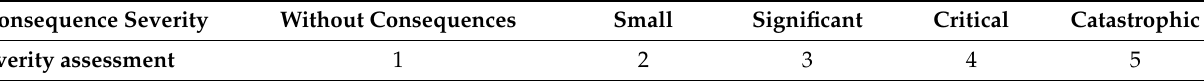
Table 2. Assessment of the consequence severity.